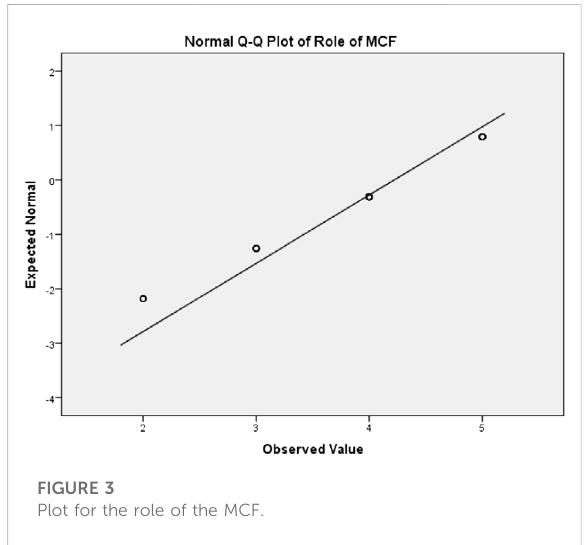
FIGURE 3 Plot for the role of the MCF.